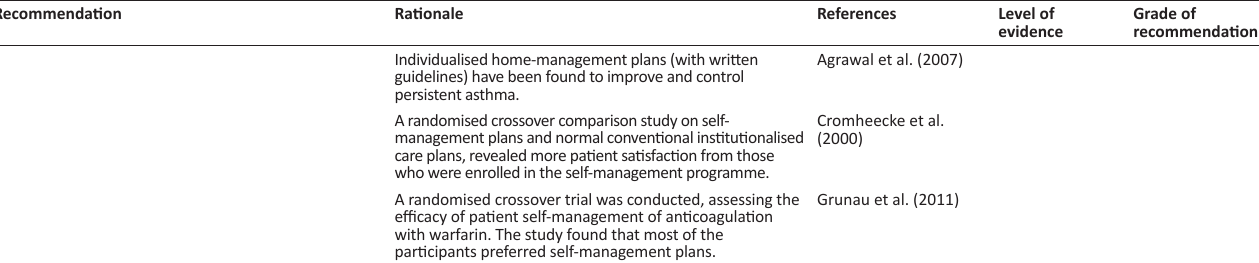
TABLE 2 (Continues...): Recommendations with level of evidence and grade of recommendation.